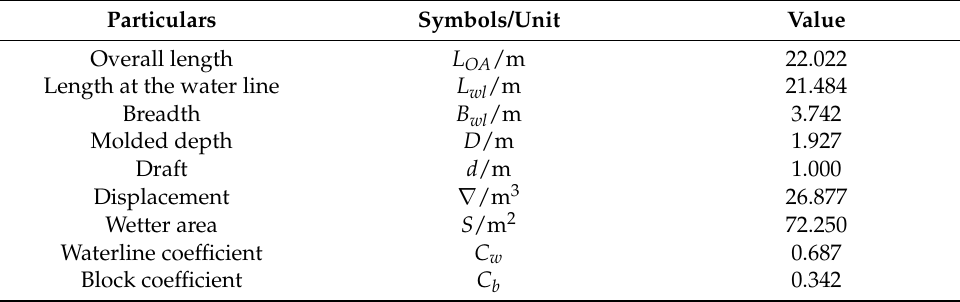
Table 1. Main particulars of the